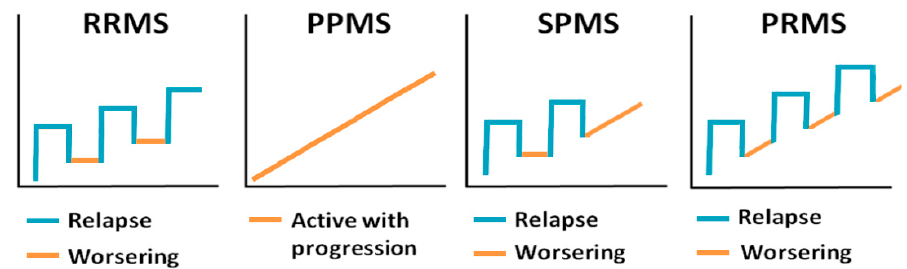
Figure 1. Clinical presentation of multiple sclerosis (MS). Relapsing–remitting MS (RRMS)—has